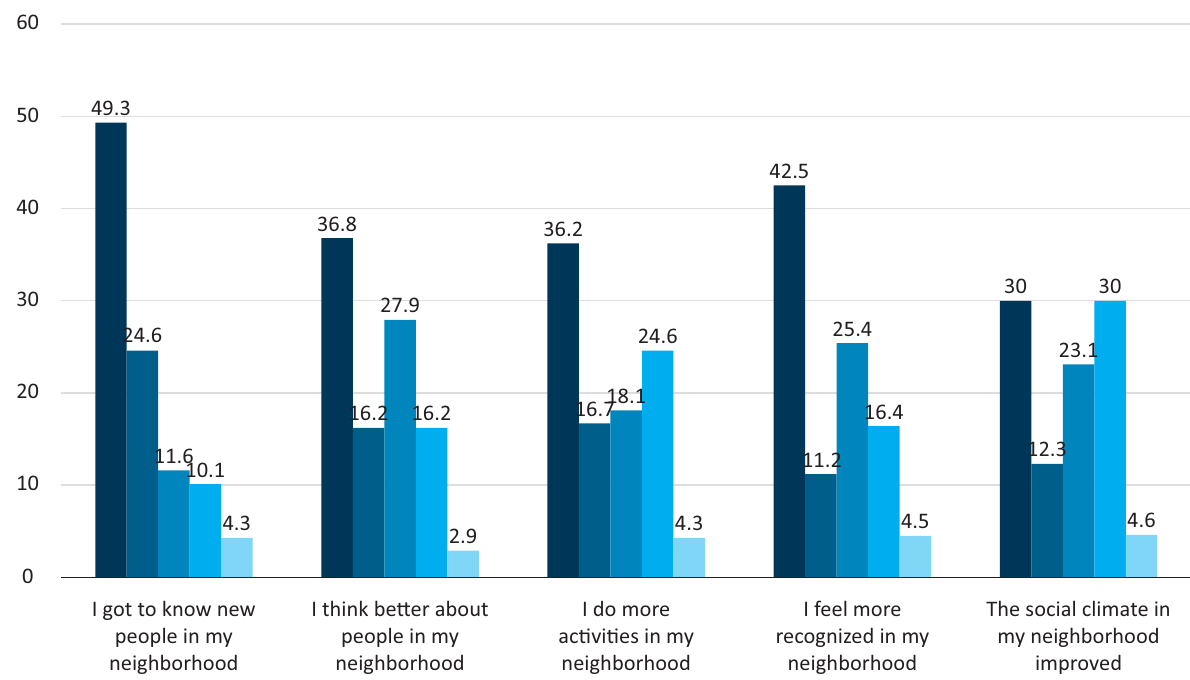
Figure 3. Schapen: By being in digital contact with my neighbors…. Note: Five‐point Likert scale—I strongly disagree, I dis‐ agree, neither/nor, I agree, and I strongly